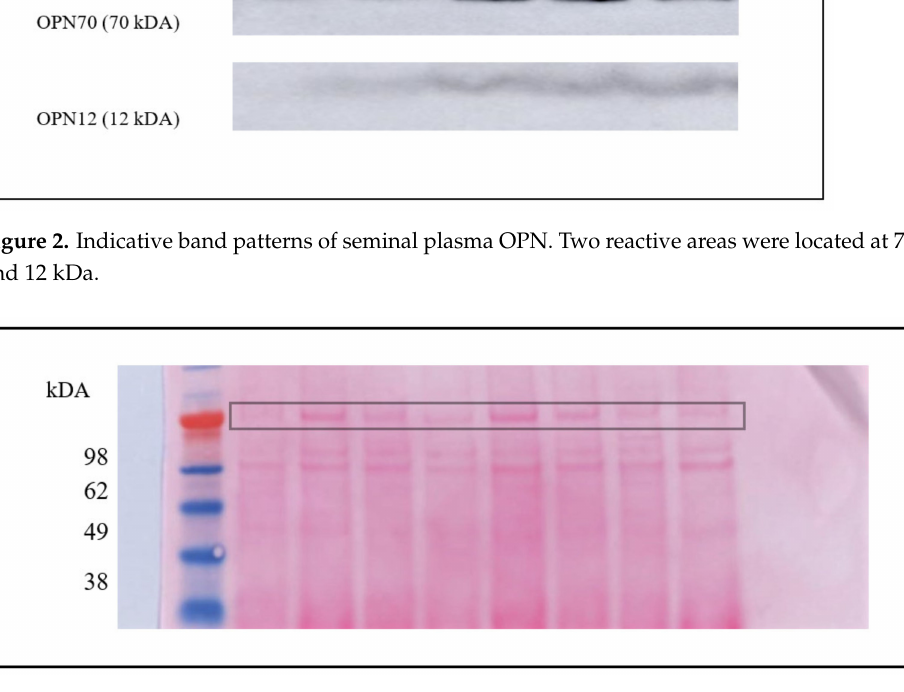
Figure 3. Nitrocellulose blot stained with Ponceau S. The protein band that was used as OPN standard is